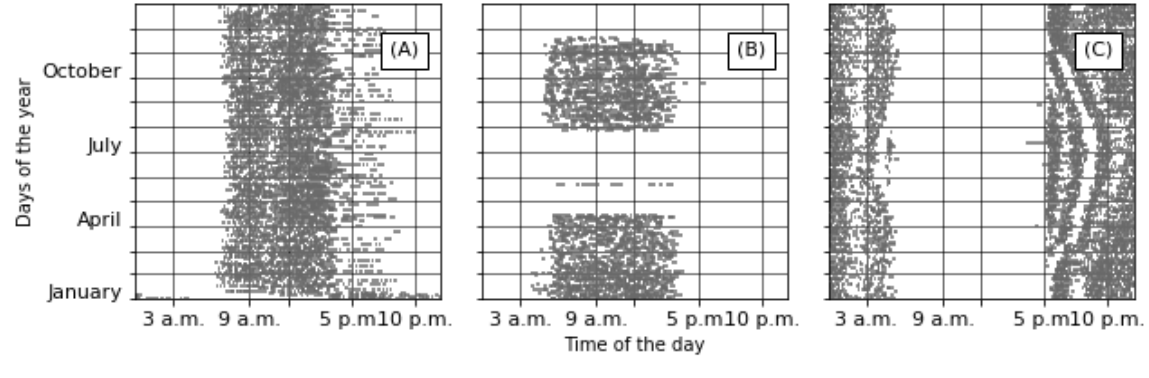
Figure 1: Taxi work during 2013 for three